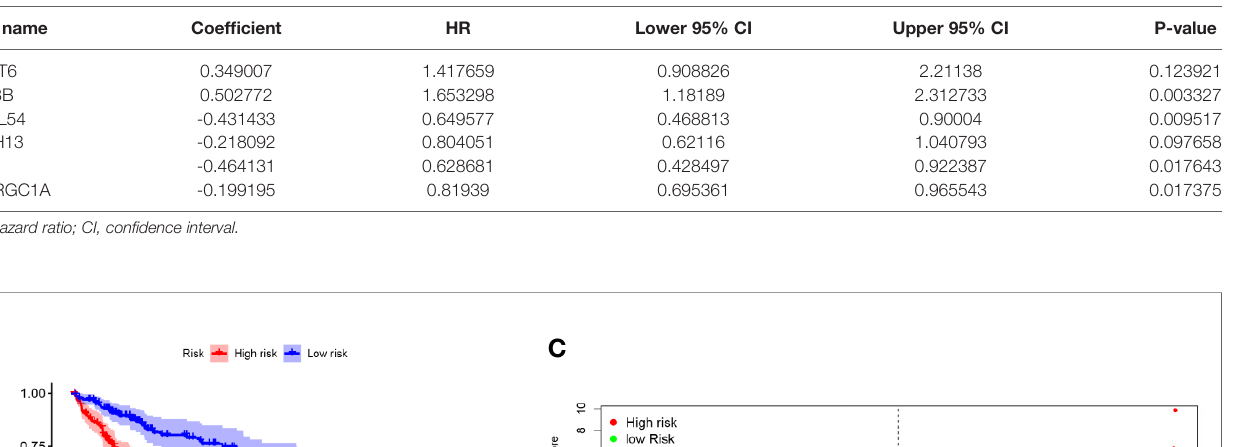
TABLE 2 | The six prognosis-associated key RBPs identi fi ed by multivariate Cox regression analysis.